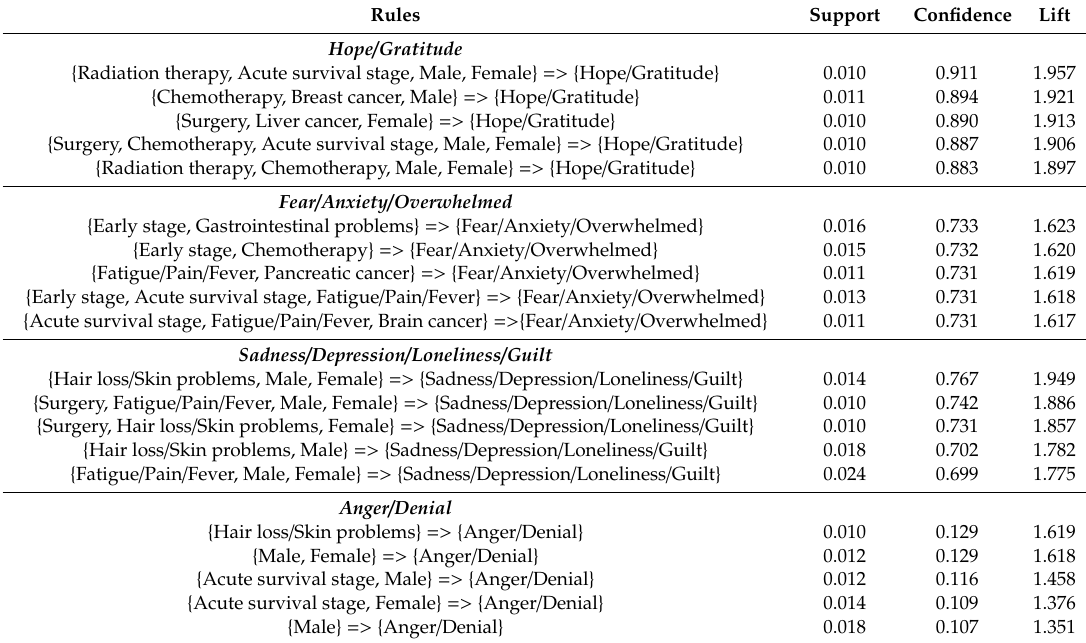
Table 2. Association rules with top five lift by